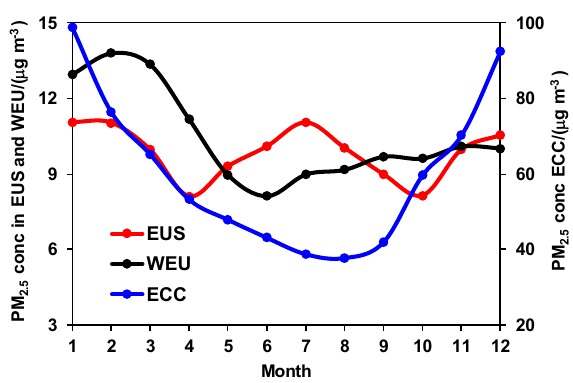
Figure 5. Monthly mean surface PM 2 . 5 concentrations during 2007–2016 in three target regions. The numbers of observational sites included in averaging are 225, 52, and 496, in the EUS, WEU, and ECC regions. Note the different scales on the y axes for EUS/WEU and